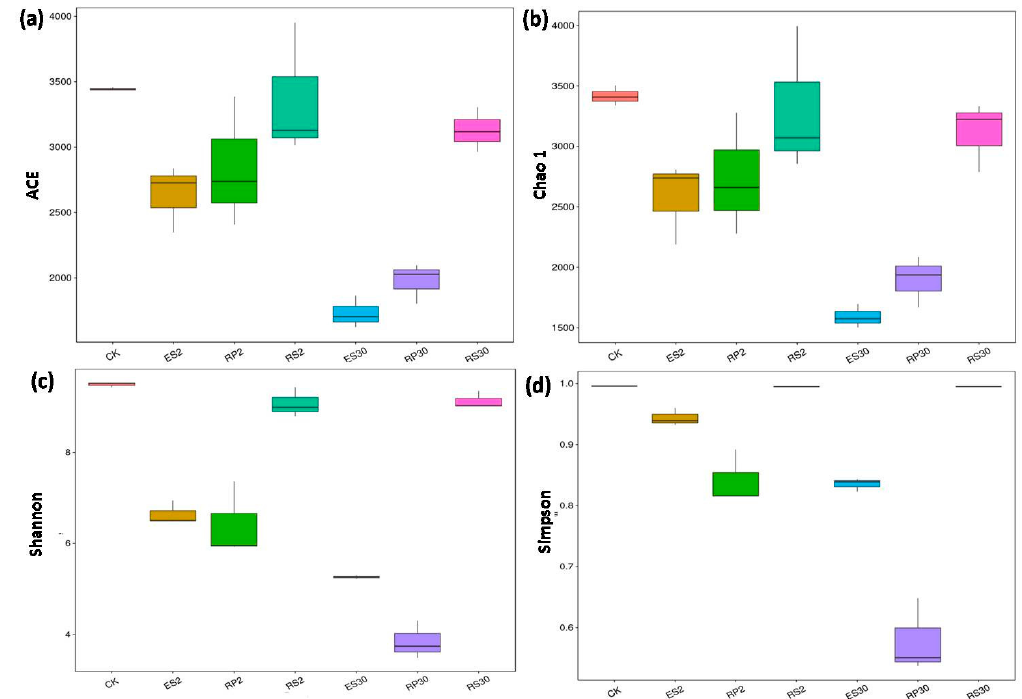
Figure 4. α -diversity indices including calculations of ( a ) abundance-based coverage estimators (ACE), ( b ) Chao1, ( c ) Shannon, and ( d ) Simpson in bulk soil (CK) and in various rhizo-compartments of different tea plantations of different ages: RS2, RP2, ES2, RS30, EP30 and ES30. β -diversity was estimated by using both weighted (based on the abundance of taxa) and unweighted (sensitive to rare taxa) UniFrac distance matrices between samples. The weighted UniFrac principal coordinate analysis (PCoA) depicted that the bacterial communities in bulk soil and the rhizosphere were separated from the rhizoplane and endosphere and clustered along the principal coordinate axis-1, while the RP and ES were clustered along axis-2 (Figure 5a). Moreover, unweighted UniFrac PCoA analysis showed that the bacterial communities in the bulk soil and rhizosphere were different from the RP and ES and clustered along principle coordinate axis-1, and method with arithmetic mean (UPGMA) clustering analysis clearly indicated the differences in same sample when analyzed in triplicate (Figure 5c). The weighted and unweighted UniFrac